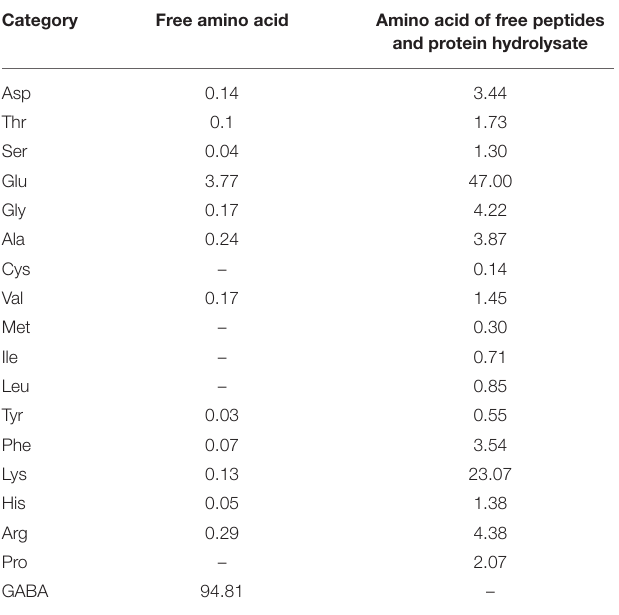
TABLE 2 | The amino acids of free amino acid and peptides in Se-MBFB (nmol%).